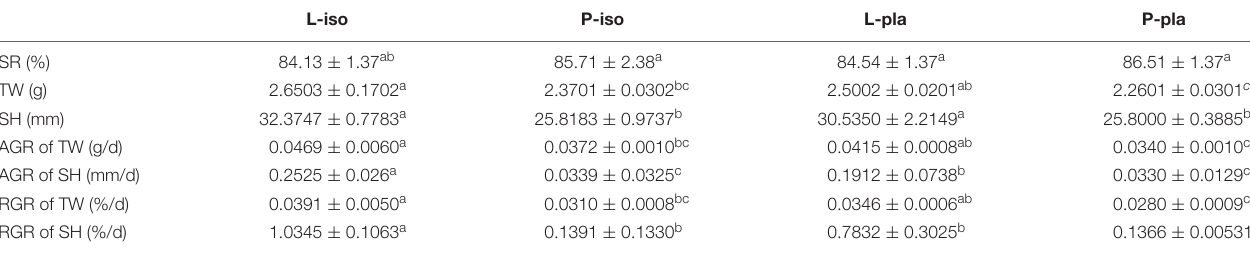
TABLE 1 | The survival and growth performance of Pinctada maxima juvenile after 30-day industrial farming. L-iso P-iso L-pla